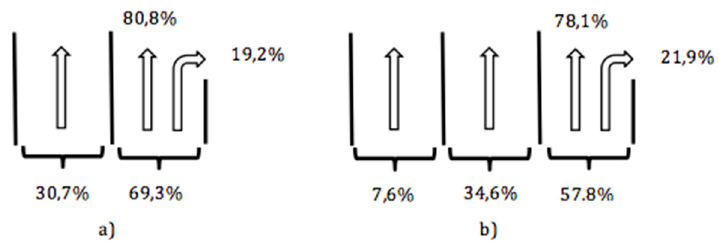
Figure 1. Average tendency to use the individual lanes at ( a ) 2-lane; ( b ) 3-lane roundabouts in Poland. Source: own research.